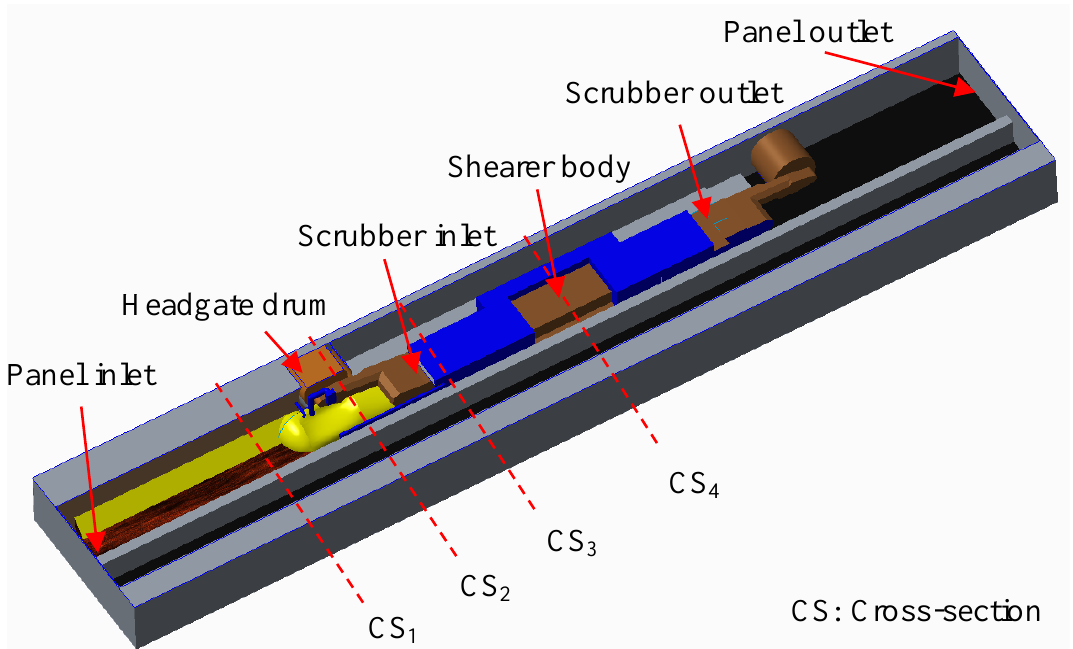
Figure 5. Three-dimensional CAD drawing of the PRL longwall test gallery.